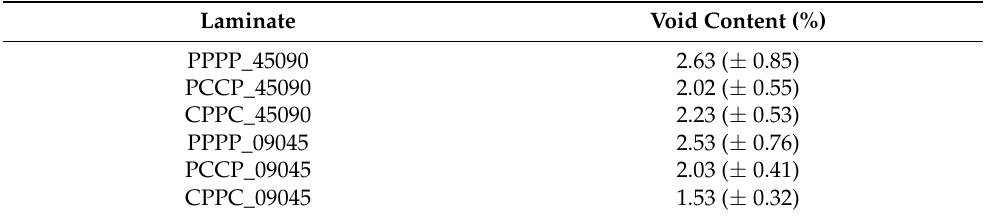
Table 4. Void contents of the laminates. The standard deviations are presented in